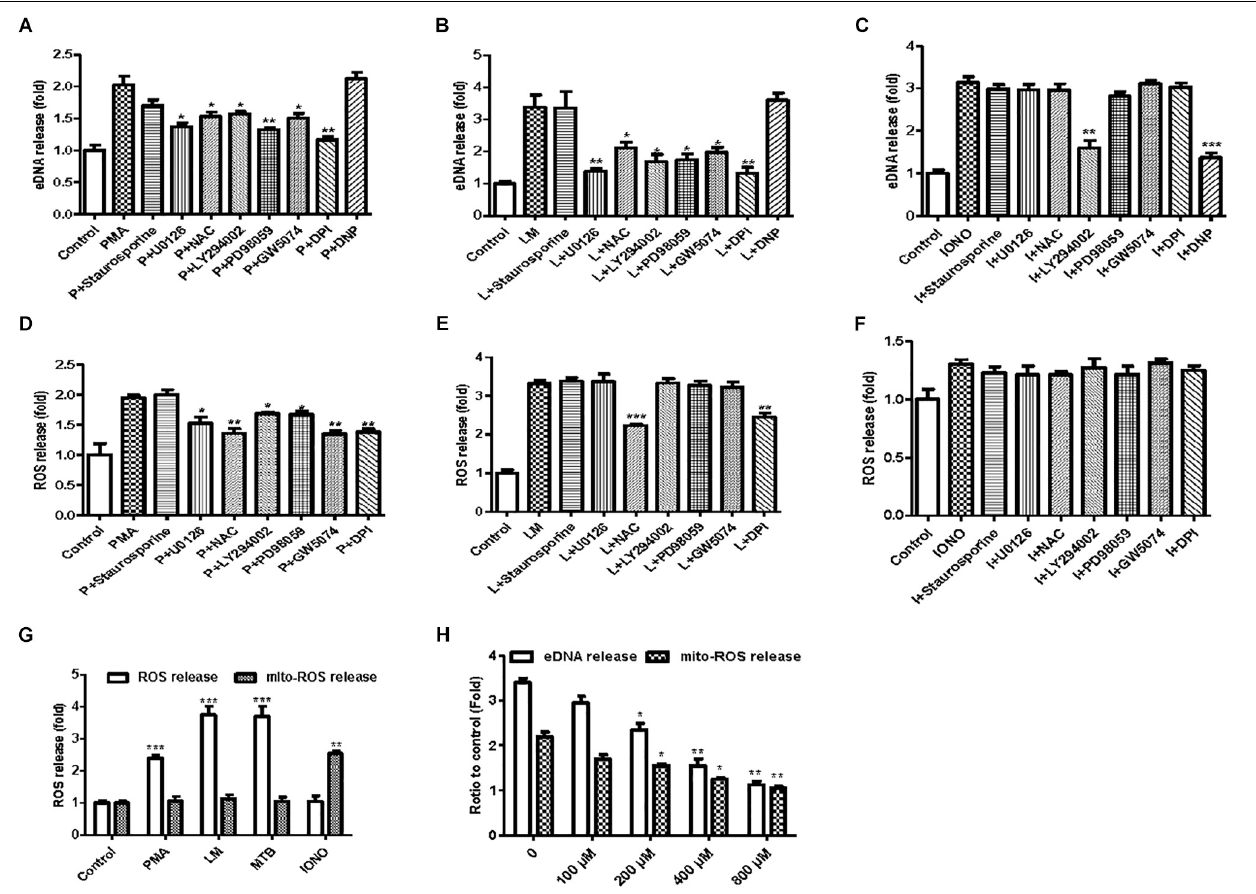
FIGURE 6 | NOX-dependent and NOX-independent MiETs. BV2 cells were pre-treated with staurosporine (10 nM), U0126 (10 µ M), PD98059 (20 µ M), DPI (50 µ M), LY294002 (50 µ M), GW5074 (10 nM), or DNP (200 µ M) for 1 h, then treated with PMA (2 µ M) (A) , Listeria (MOI = 50:1) (B) , or IONO (1.5 µ M) (C) for 2 h. Then, eDNA contents were detected. For the quantification of cytosolic ROS release, BV2 cells were pre-treated with similar inhibitors (except DNP) for 1 h and then treated with PMA (2 µ M) (D) , Listeria (MOI = 50:1) (E) , or IONO (1.5 µ M) (F) for 2 h. Cytosolic ROS and mitochondrial ROS release were detected in PMA-, Listeria- and IONO-treated BV2 cells (G) . BV2 cells were pre-treated with a series of concentrations of DNP (100–800 µ M) for 1 h and then treated with 1.5 µ M ionomycin for 30 min. eDNA and mitochondrial ROS were detected on a plate reader (H) . ∗ p < 0.05, ∗∗ p < 0.01, ∗∗∗ p < 0.001, compared with the control cells. The data are representative of triplicate experiments and presented as the mean value ± the